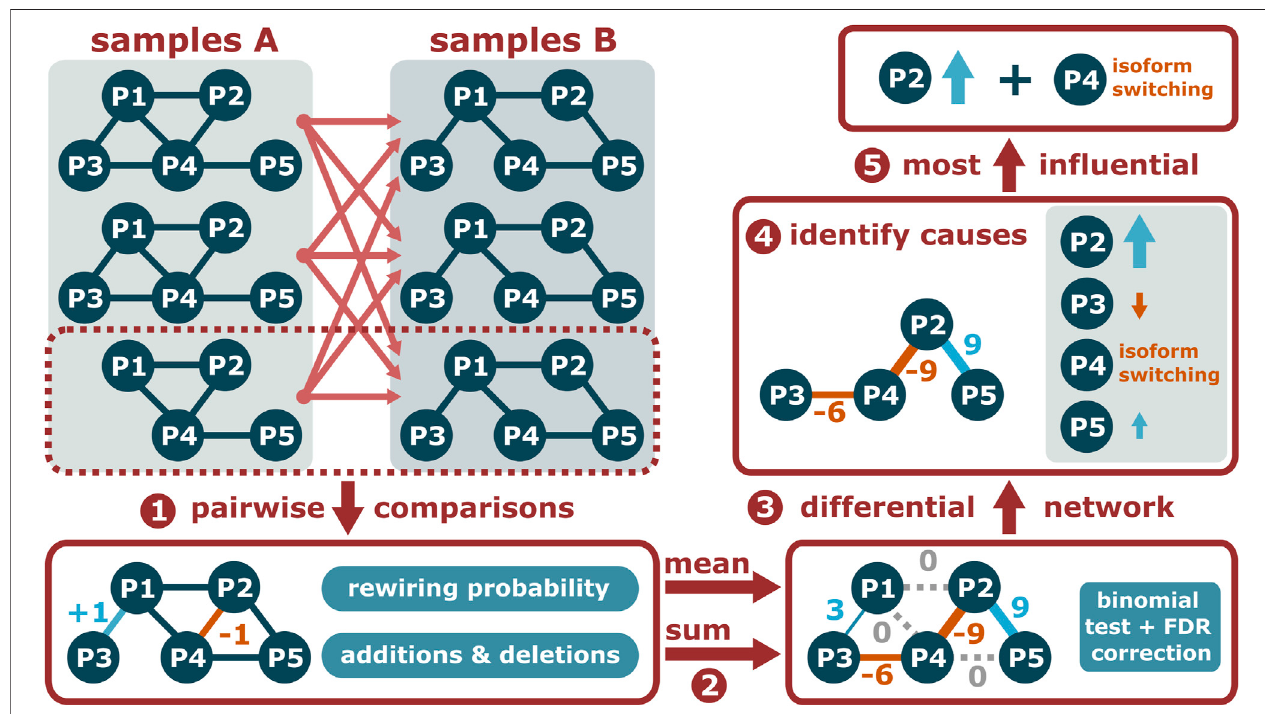
FIGURE 3 | Given two sets of condition-speci fi c PPI networks, PPICompare counts the added and deleted interactions for each pairwise comparison and the comparison-speci fi c rewiring probability (1). Then, the overall differential PPI network is constructed by summarizing the individual comparisons (2) and identifying the statistically signi fi cant rewiring events (3). Finally, the causal reason of each rewired interaction is identi fi ed (4) and a small set of causes that can explain all of them is determined